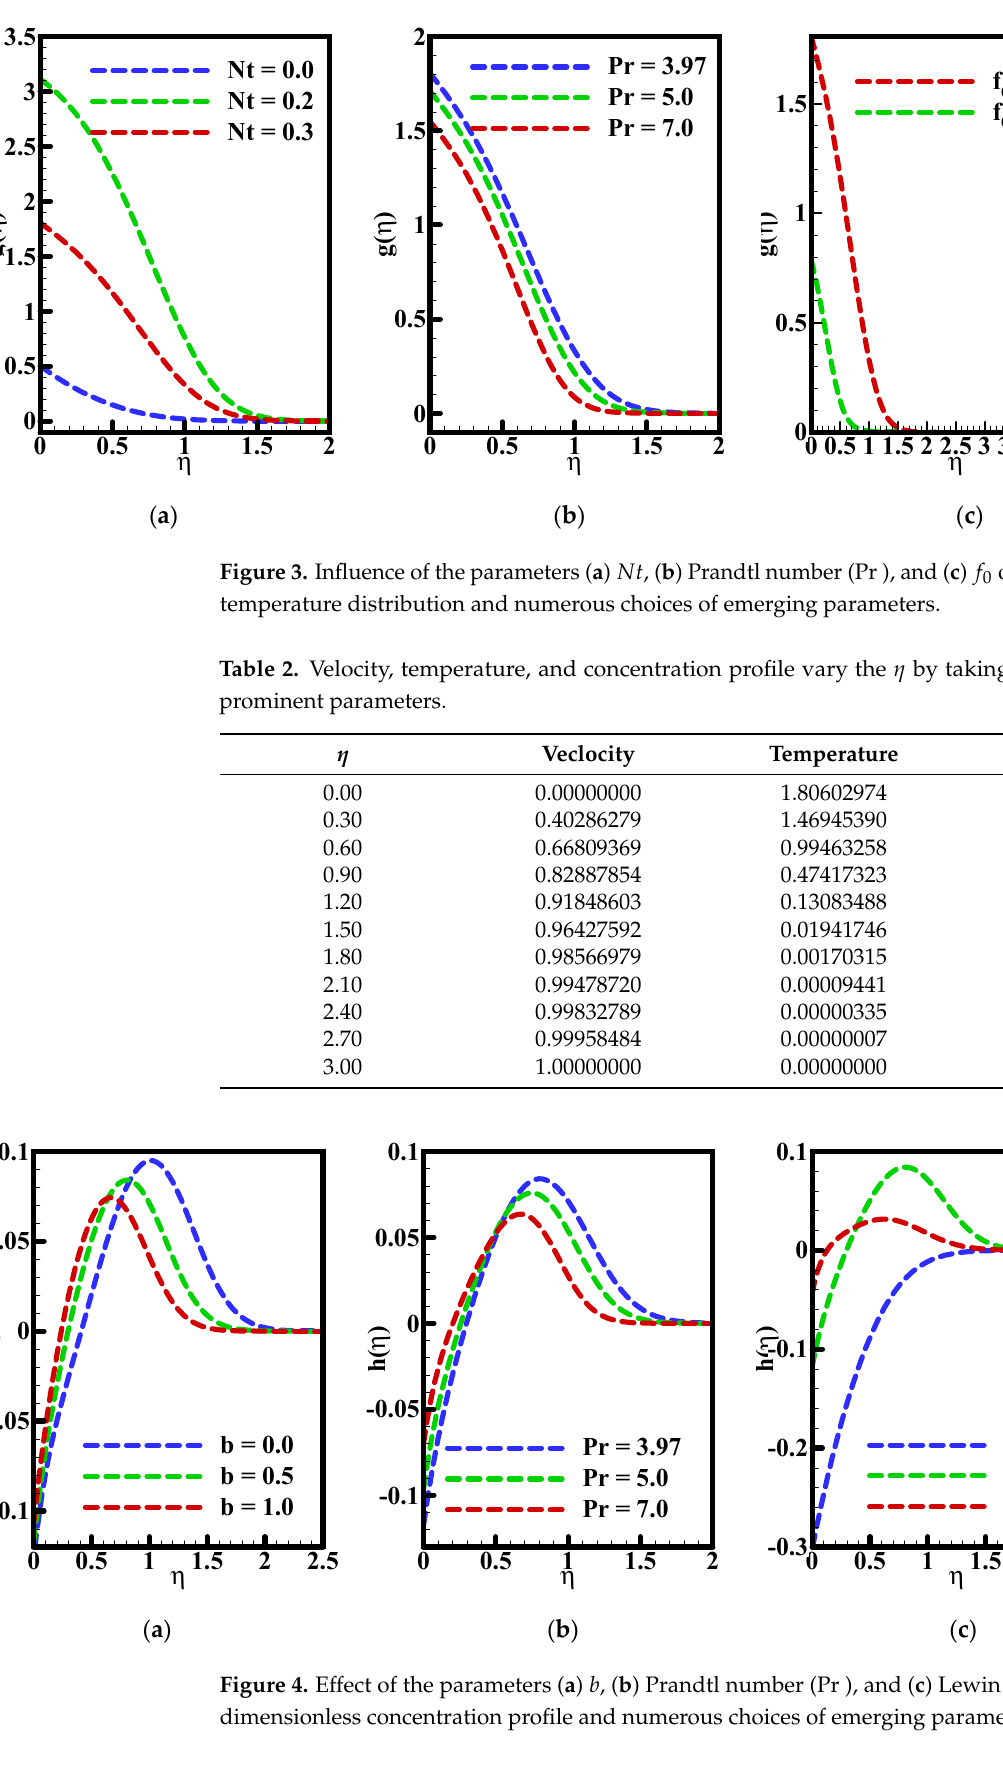
( c ) Figure 5. Comparison between the obtained solution with the collocation method (CM) and fourth- order Runge–Kutta (RK-4) of the dimensionless ( a ) velocity, ( b ) temperature, and ( c ) concentration profiles as varying Ha .